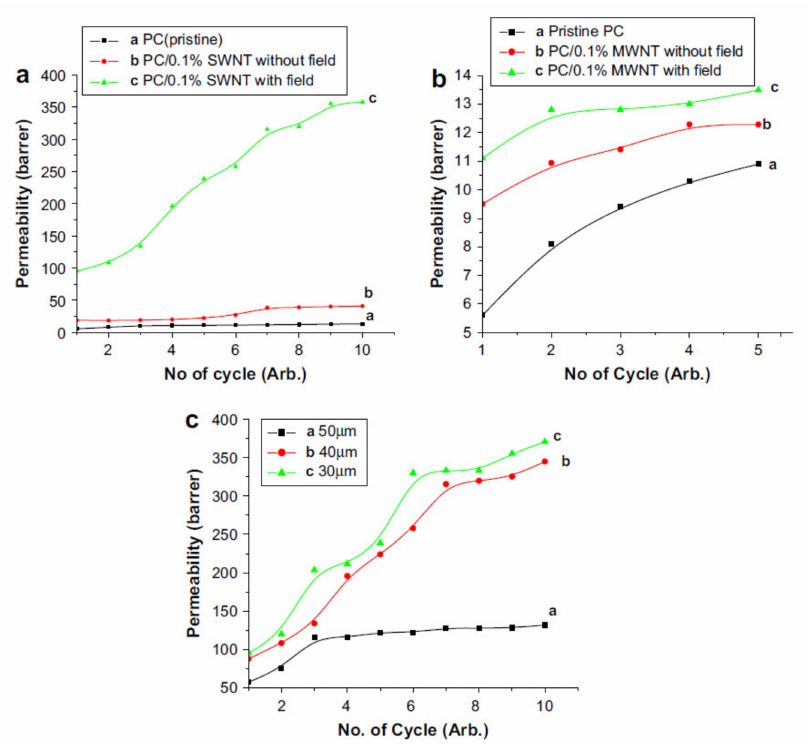
Figure 13. Permeation of hydrogen gas through: ( a ) pristine/0.1% single-walled carbon nanotubes (SWNT) composite membrane; ( b ) pristine/0.1% multi-walled carbon nanotubes (MWNT) composite membrane; ( c ) the dependence of gas permeation on thickness (used with copyright permission)